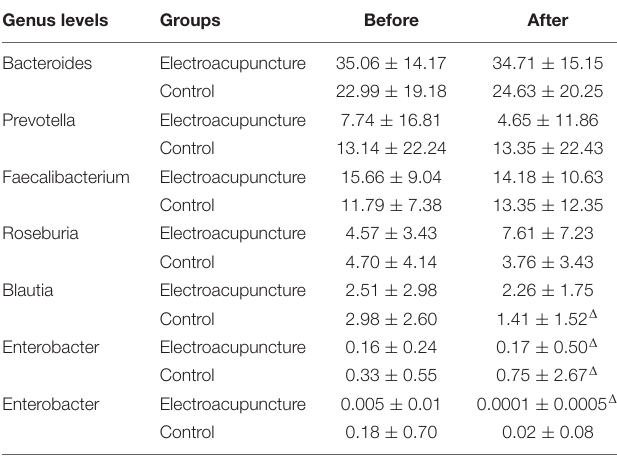
TABLE 5 | Comparison of genus level between two groups of patients before and after treatment (x ± s). Genus levels Groups Before After